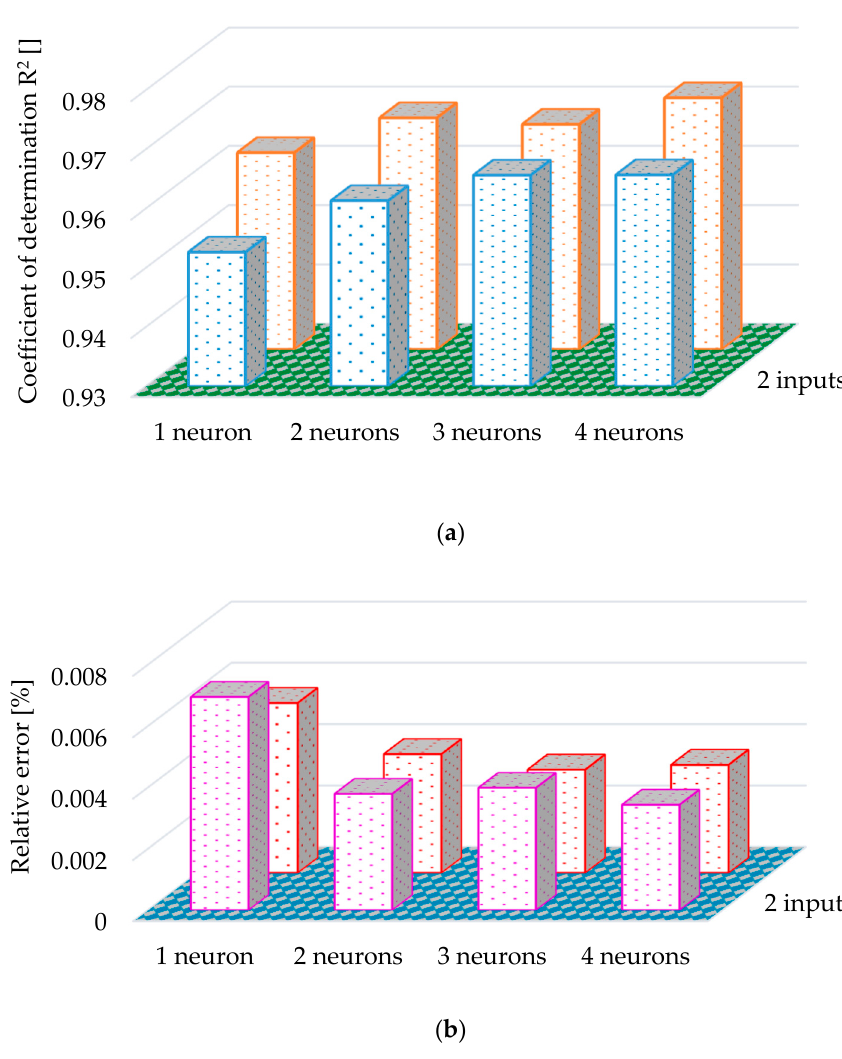
Figure 3. Summary of learning results for the best-adjusted neural networks for the characteristic of specific hourly fuel consumption. The calculated determination coefficient R 2 and the relative error between the model and actual data; 1st and 2nd inputs: engine rotational speed and engine torque; 3rd input: vehicle gear number; 4th input: vehicle speed: ( a ) coefficient of determination R 2 [-]; ( b ) relative error [%].